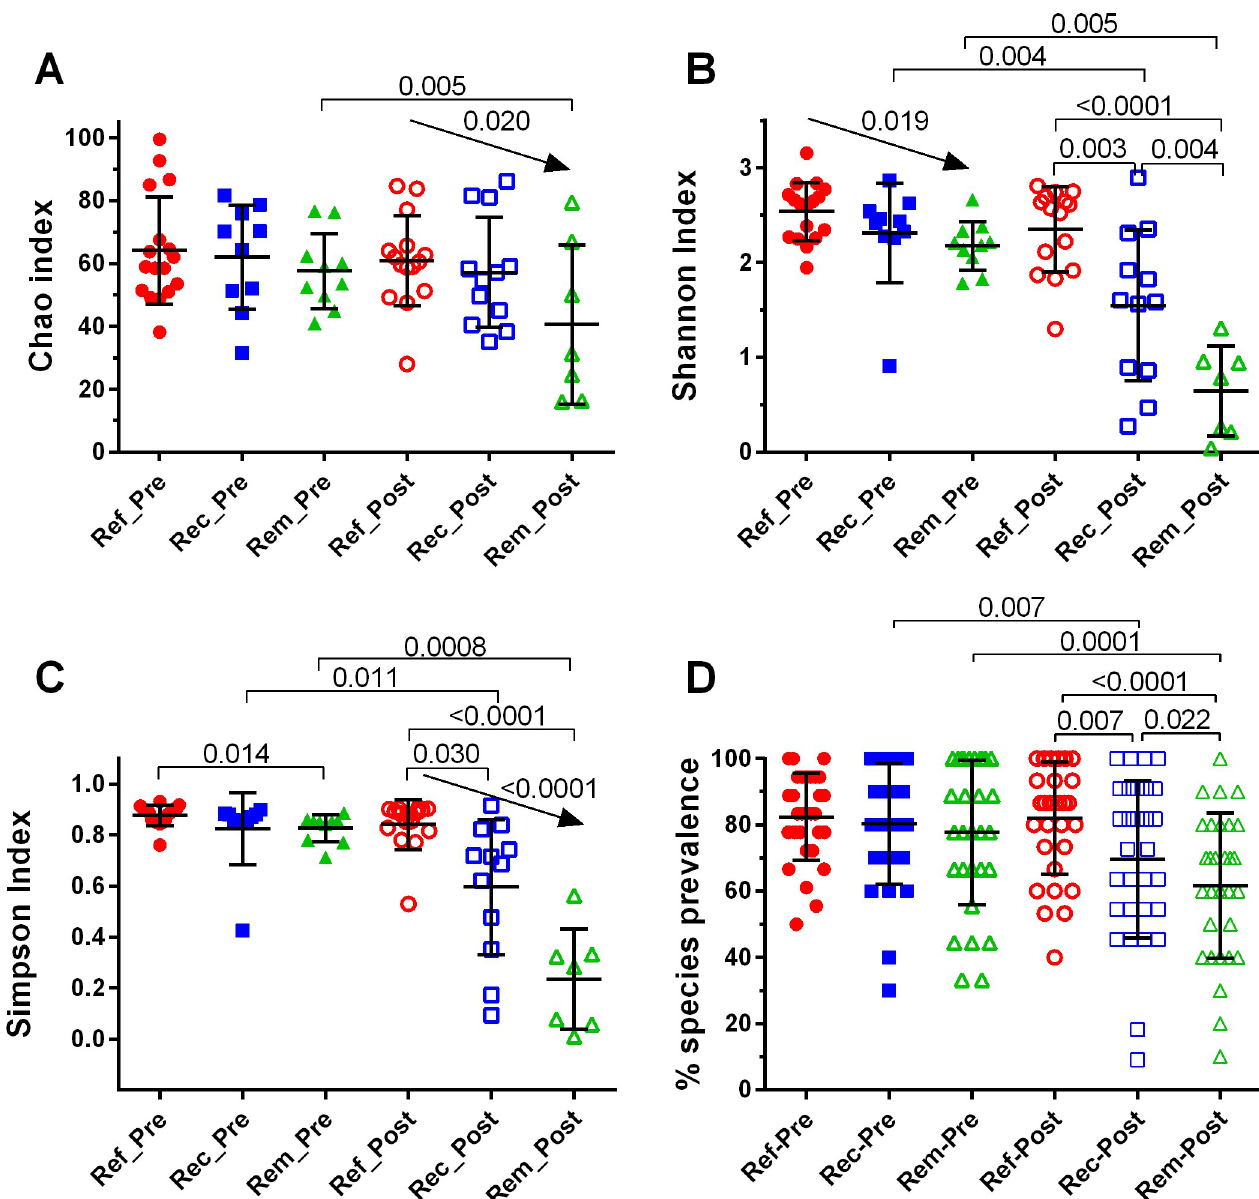
Fig 2. Alpha diversity indices among clinical outcome groups pre- and post-treatment. Index values for Chao, Shannon, and Simpson were determined using Microbiomeanalyst.ca with the unfiltered 5011 OTU dataset and Total Sum Scaling (TSS). % species prevalence was calculated based on the percent of species-positive samples versus total samples within each group and treatment, including only the 30 most prevalent species. Scatterplots showing mean and standard deviation, and statistical analyses were performed in GraphPad Prism; only significant p values or trends are shown. Between outcome comparisons of normally distributed Chao indices were analyzed by ANOVA with Holm-Sidak’s multiple comparisons test; non-normal Shannon and Simpson indices were analyzed by Kruskal-Wallis tests, with Dunn’s multiple comparisons tests. Pretreatment versus posttreatment comparisons were performed for Chao and % species prevalence by paired t-tests and for Shannon and Simpson by Wilcoxon matched-pairs signed rank tests (GraphPad